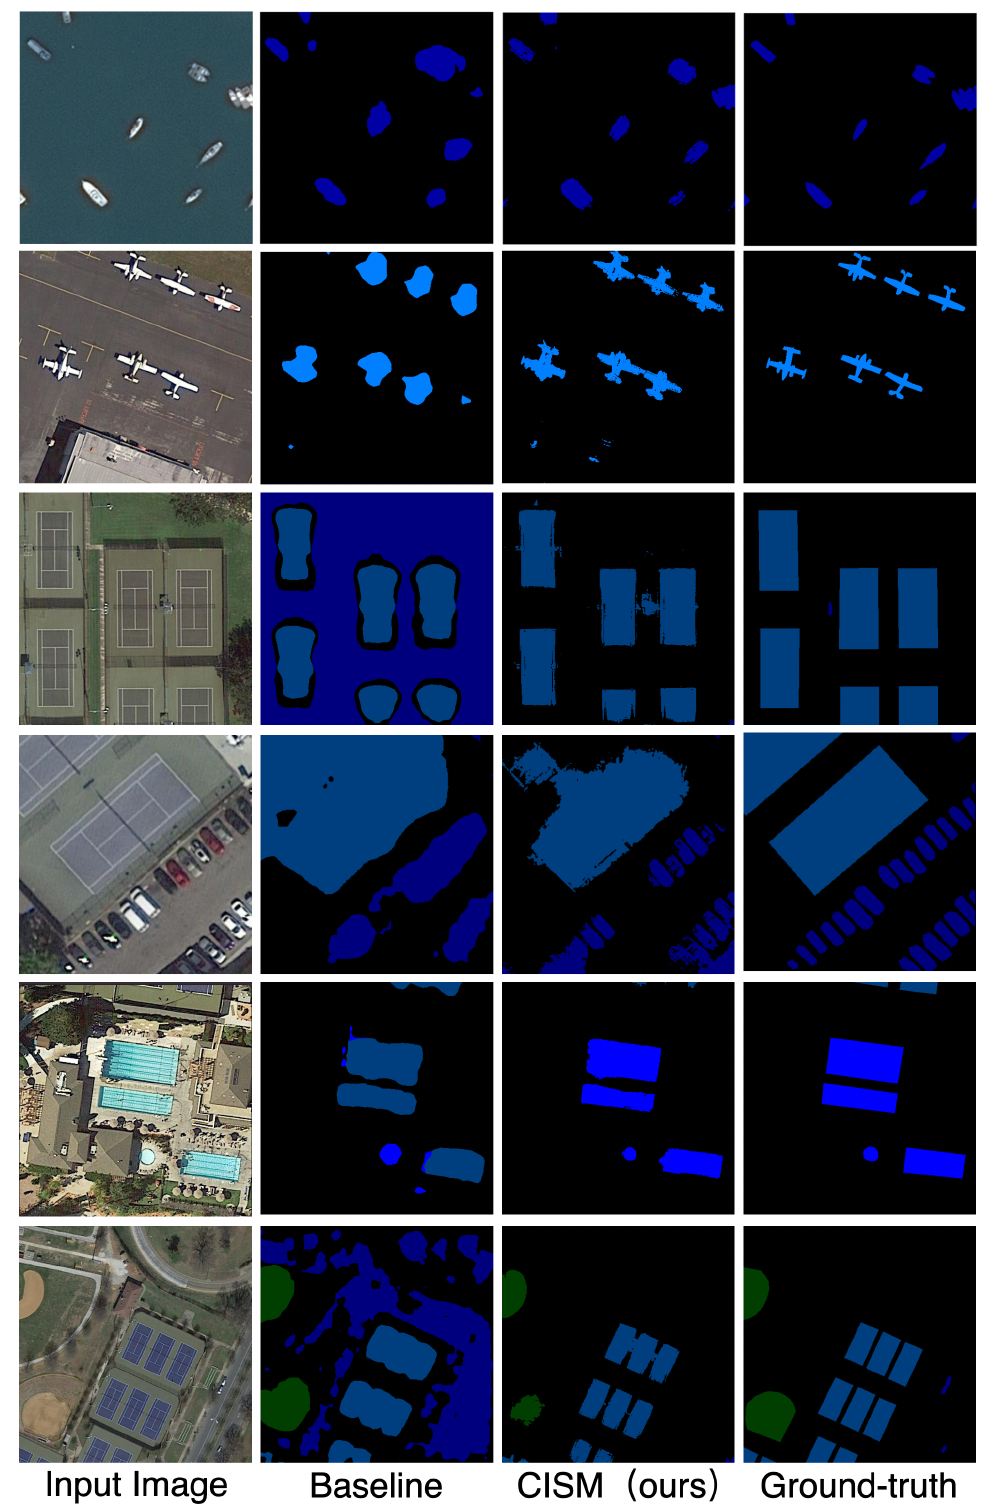
Figure 7. Visual illustration of the segmentation results of the iSAID dataset. The six rows show the results of the qualitative semantic segmentation to demonstrate how our CISM outperforms the baseline. Best viewed in